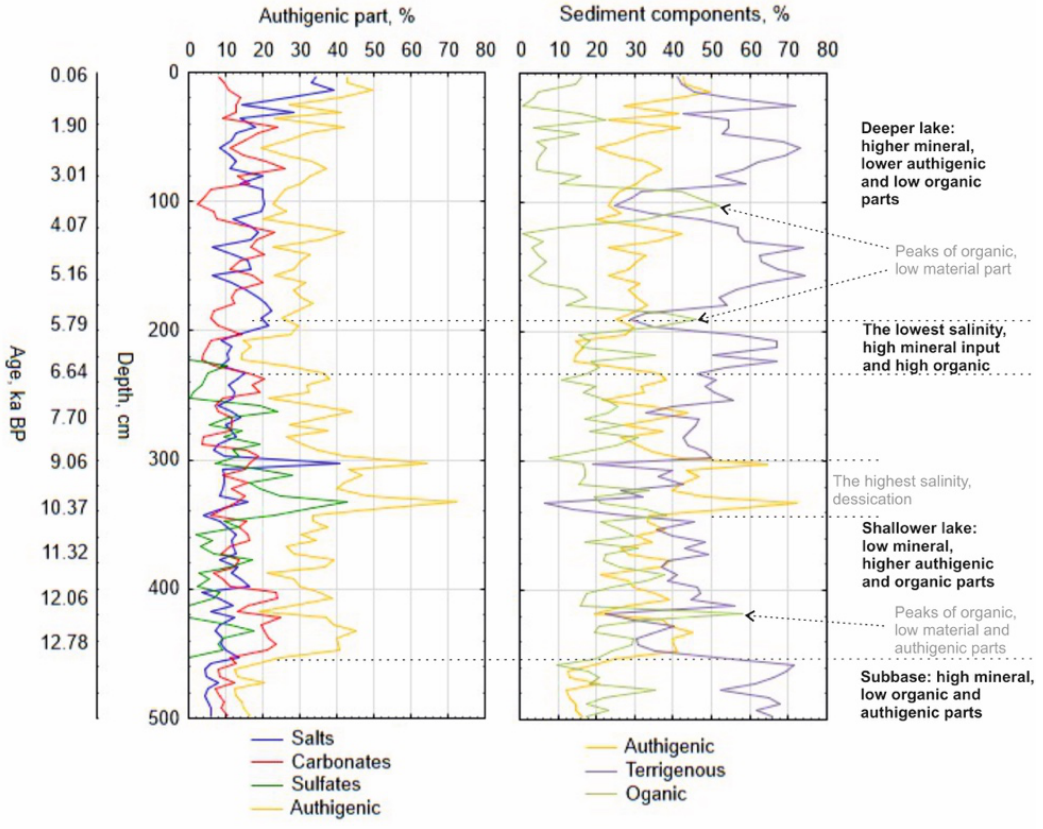
Figure 5. Changes of terrigenous, organic and authigenic fractions along the sediment core and their environmental interpretation.